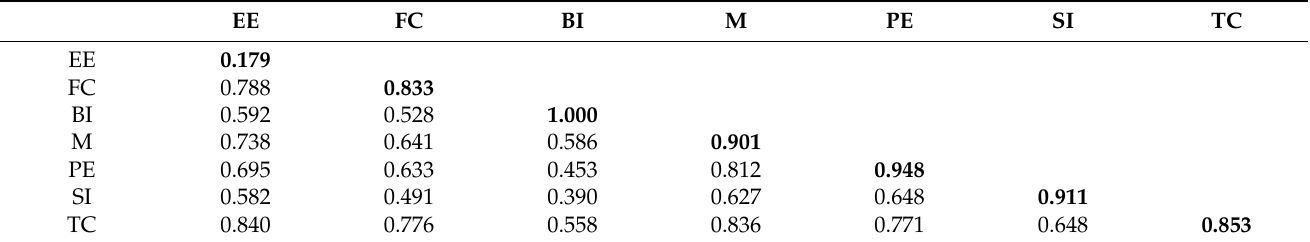
Table 2. Discriminant validity: the bolded values are AVE squares.